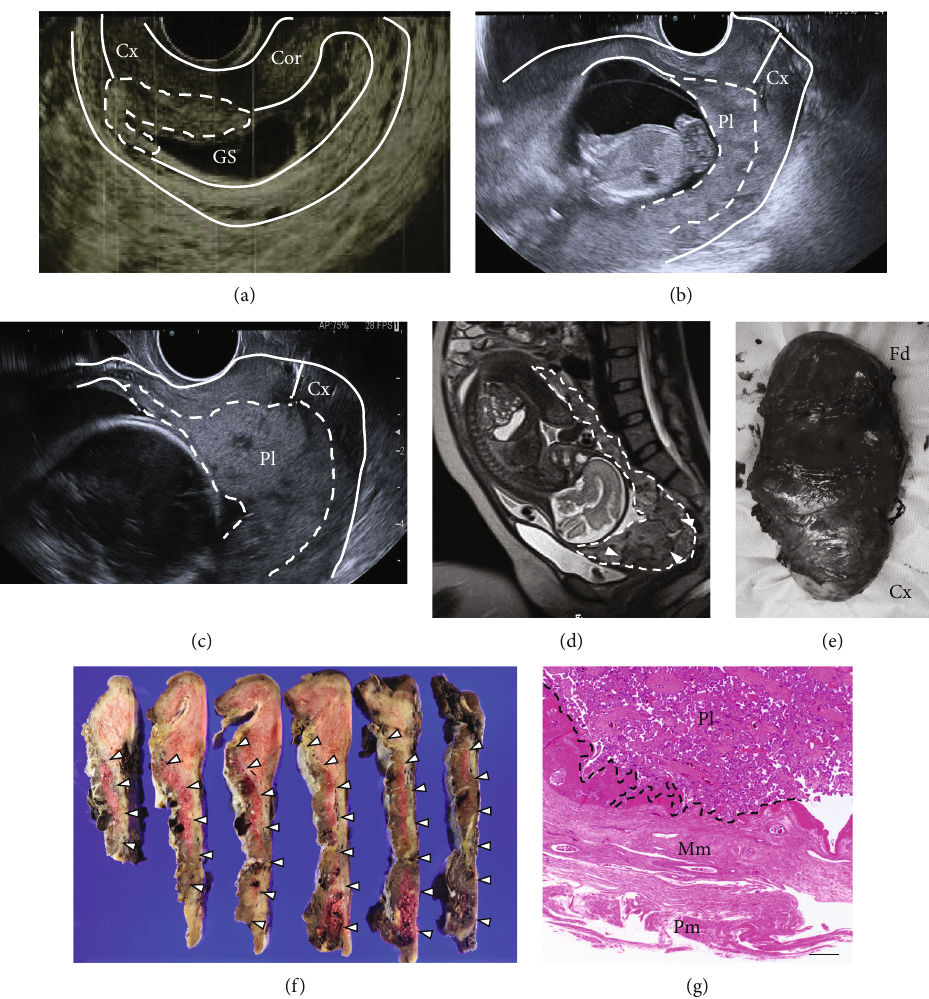
Figure 1: (a) – (c) Transvaginal ultrasound fi ndings. (a) Low implantation of the gestational sac and the placenta attached to the posterior wall of the uterus (dotted line) are observed at 7 weeks of gestation. The anterior myometrium including the cesarean scar is intact. (b) The cervical length is 14 mm at 13 weeks of gestation. (c) Placental insertion into the cervix and cervical shortening are noted at 20 weeks of gestation. (d) Magnetic resonance imaging fi ndings at 30 weeks of gestation. Sagittal T2-weighted half Fourier single-shot turbo spin echo (HASTE) sequence images show the insertion of the placenta into the e ff acement of the cervical canal, intraplacental vasodilatation (white arrowheads), and heterogeneity within the placenta. (e) Surgical specimen of cesarean hysterectomy. A swollen lower uterine segment is noted. (f) and (g) Histopathological fi nding. (f) White arrowheads indicate the boundaries of the placenta and myometrium. The placenta extensively adhered to the anteroposterior wall from the lower uterine segment to the cervix. (g) The placenta invading the myometrium (dotted line) is observed. The scale bar indicates 500 μ m. GS, gestational sac; Cx, cervix; Cor, corpus of the uterus; Pl, placenta; Fd, fundus; Mm, myometrium; Pm,